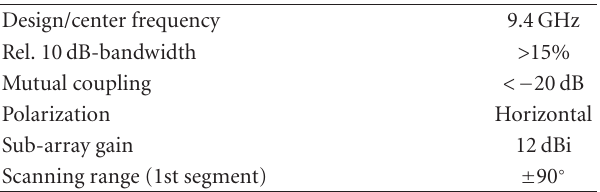
Figure 1: Subarray consisting of four patch antenna elements with common feed. Table 1: ERAKO system parameter overview.